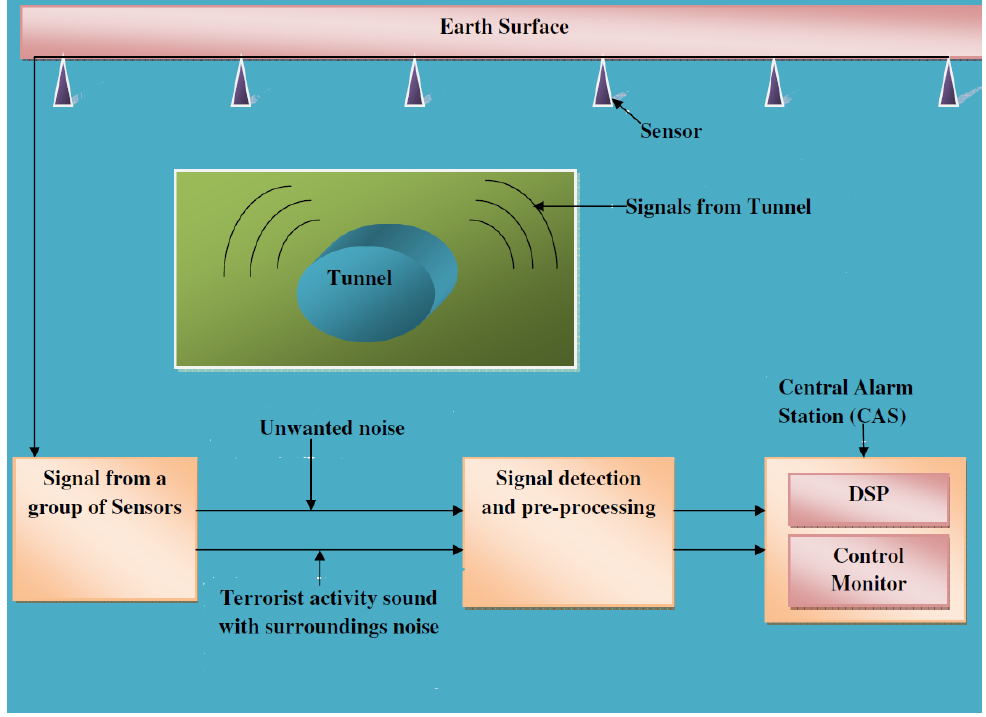
Figure 6. Signal detection system for tunnel